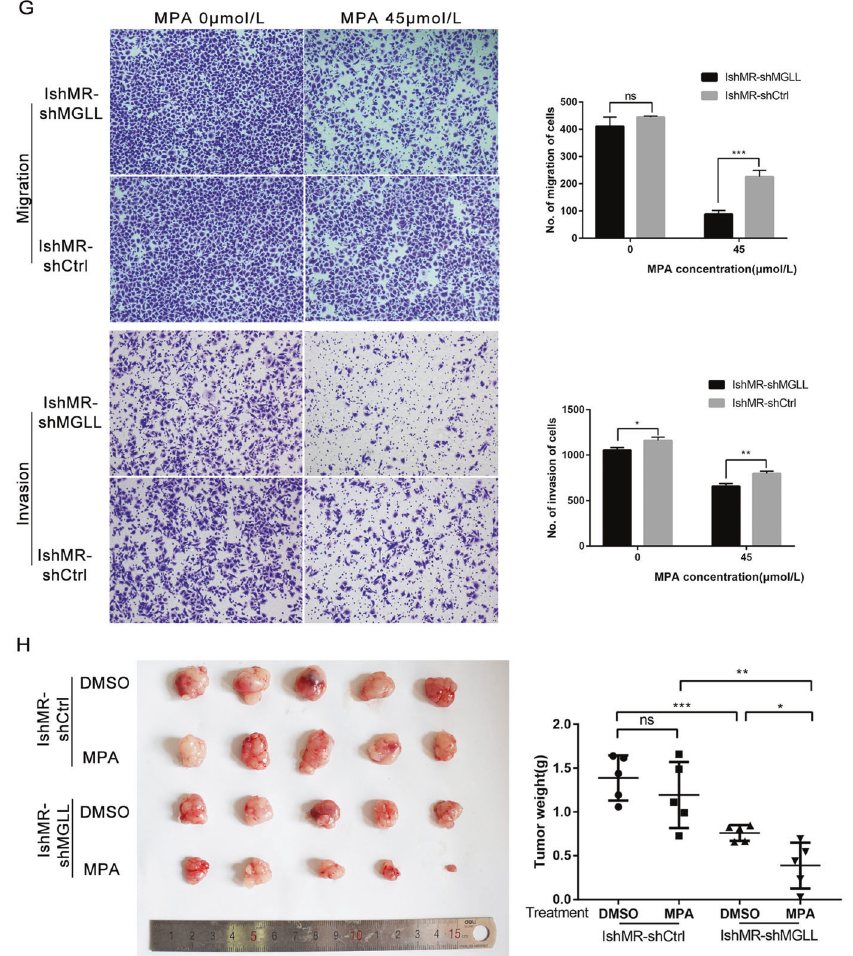
Fig. 5 MGLL knockdown renders EAC cells more sensitive to progesterone. A Western blot assay was used to detect the protein expression of MGLL in IshMR-shMGLL and IshMR-shCtrl cells. B qRT-PCR assay was used to detect the mRNA expression of MGLL in IshMR-shMGLL and IshMR-shCtrl cells. C MTT assay was used to detect the viability of IshMR-shMGLL and IshMR-shCtrl cells with different-dose MPA. D The proliferation capacity of IshMR-shMGLL and IshMR-shCtrl cells with 0 or 90 μ M MPA treatment by EDU assay. E Apoptotic cells in IshMR- shMGLL and IshMR-shCtrl groups with 0,90 μ M MPA for 48 h respectively. Apoptosis was detected by fl ow cytometry after staining with FITC Annexin-V and PI. F Expression of MGLL, CDK4, CyclinD1, Bcl-2, cleaved-PARP and cleaved caspase3 were determined by Western blot assay in IshMR-shMGLL and IshMR-shCtrl cells were treated with 0,90 μ M MPA for 48 h respectively. G Ability of migration and invasion in IshMR- shMGLL and IshMR-shCtrl cells treated with 0,45 μ M MPA for 48 h respectively by transwell assay. H The left image shows the tumors transfected with IshMR-shMGLL and IshMR-shCtrl treated with MPA or DMSO. The right image shows the tumor weights of the four groups of mice. All experiments were repeated three times at least. * P < 0.05, ** P < 0.01, *** P < 0.001, and **** P < 0.0001 for statistical analysis of the indicated